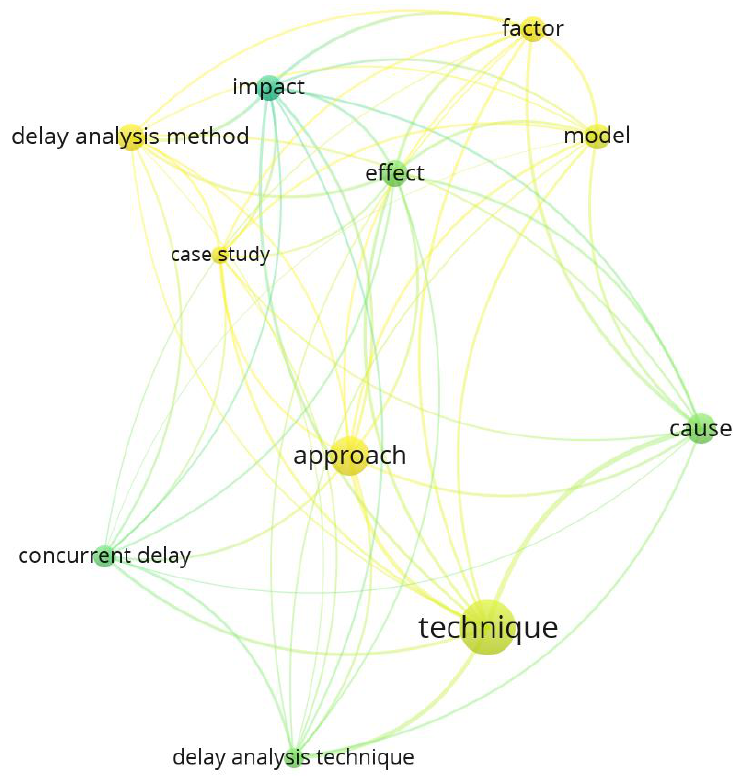
Figure 4. Mapping the items repeated in documents. Table 2. Mapping the Items Repeated in